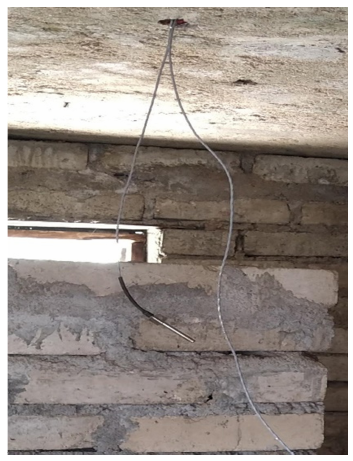
Figure 10. Sensor in fly-ash brick model house.